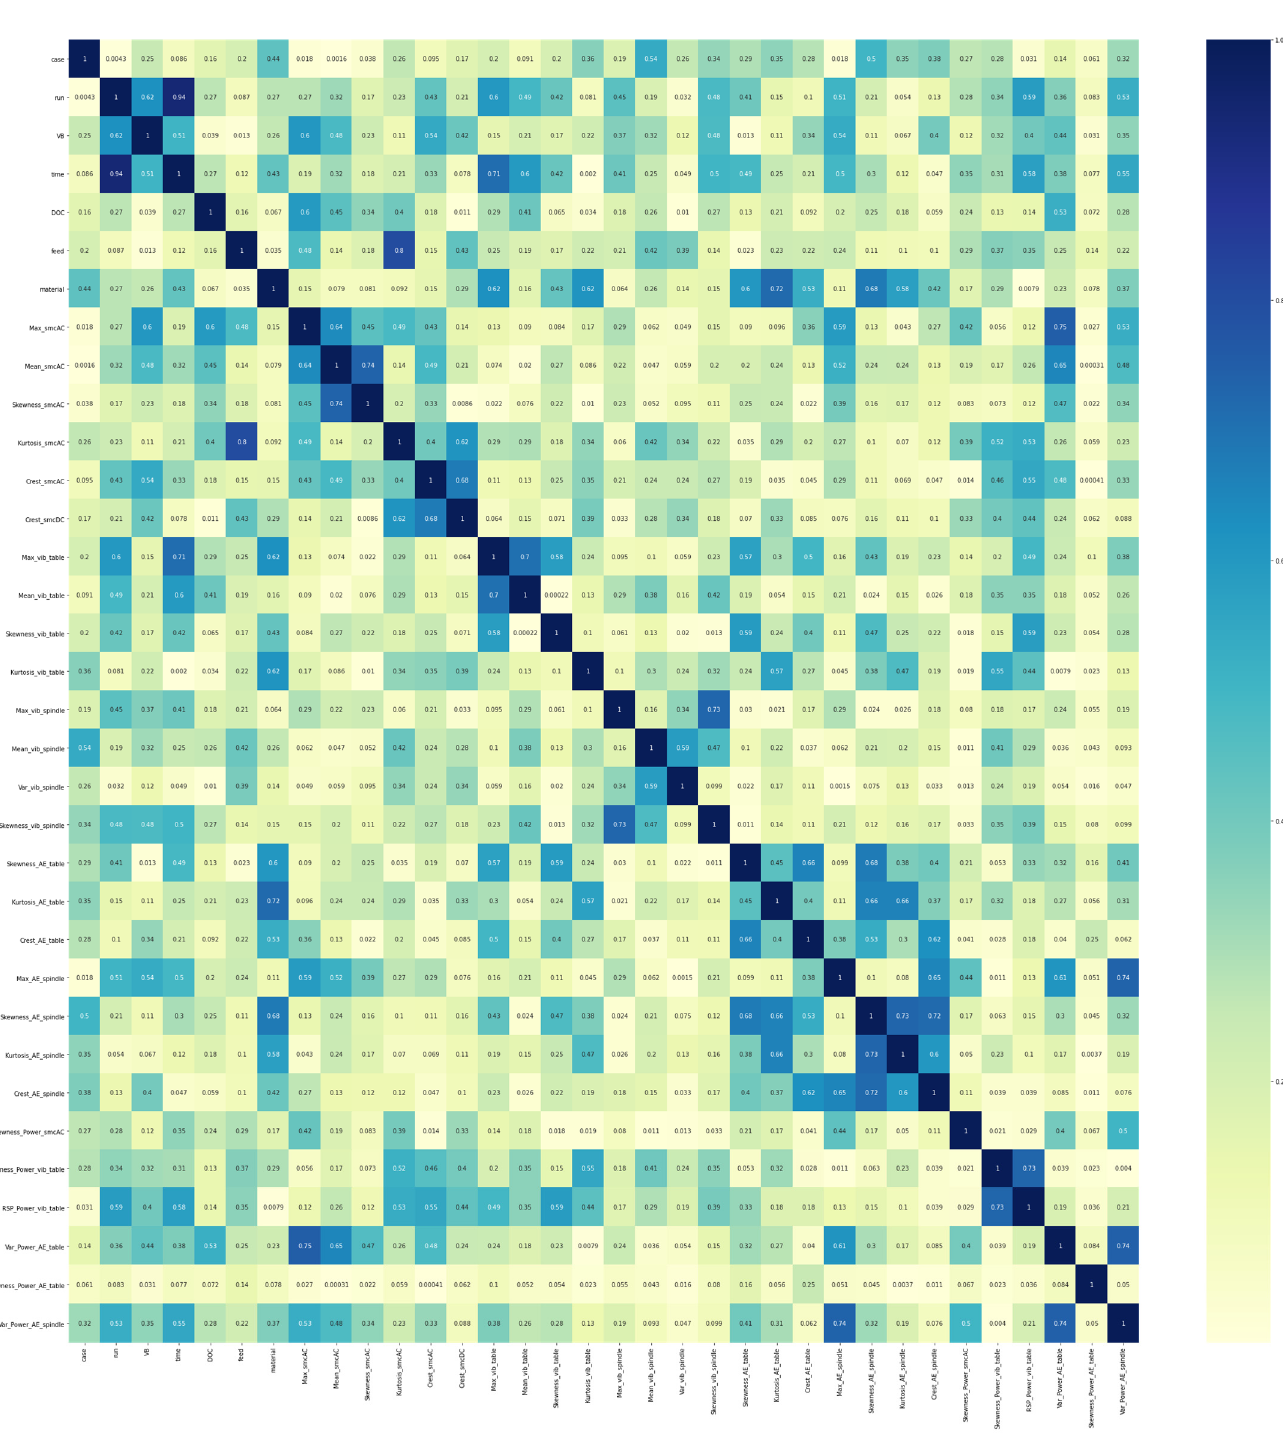
Figure A2. Correlation matrix of final set of features.